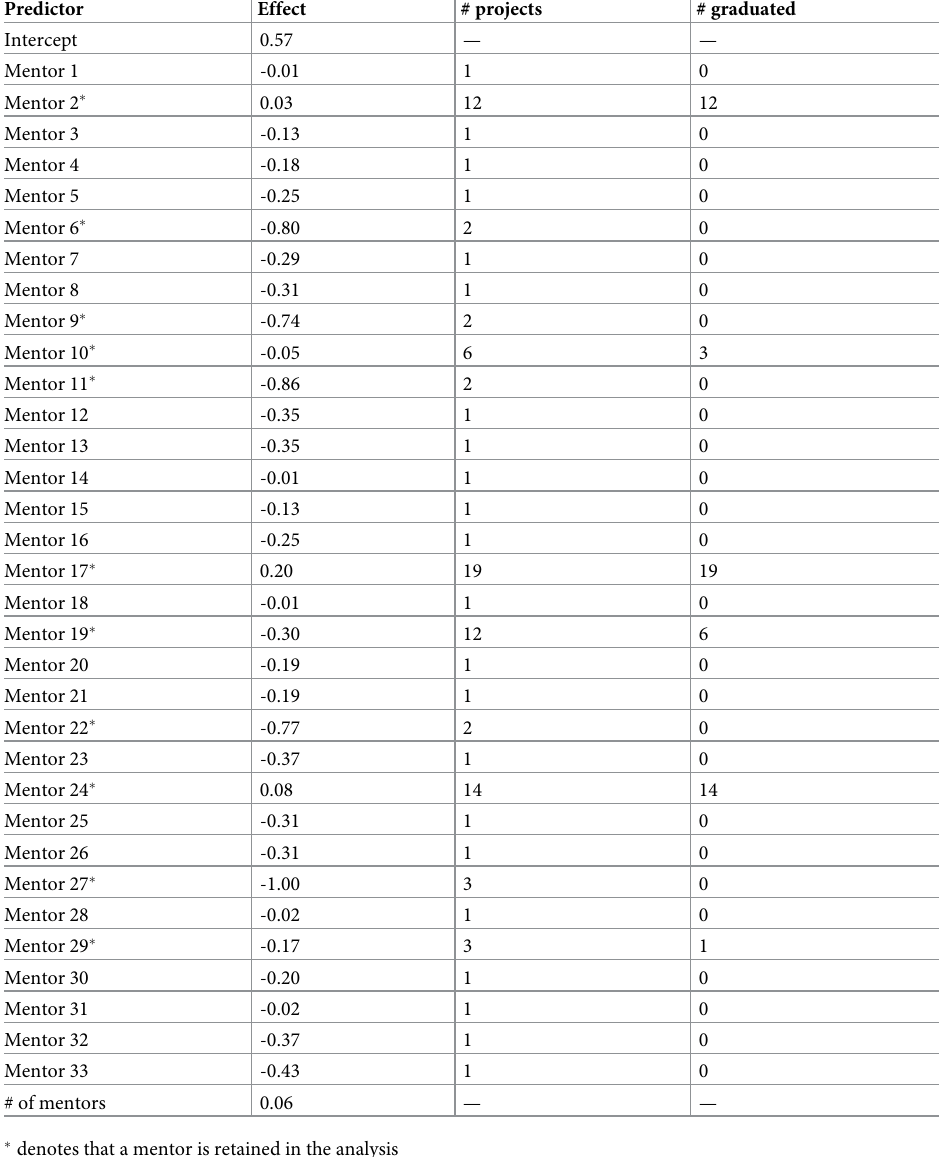
Table 1. Coefficient estimates from LASSO